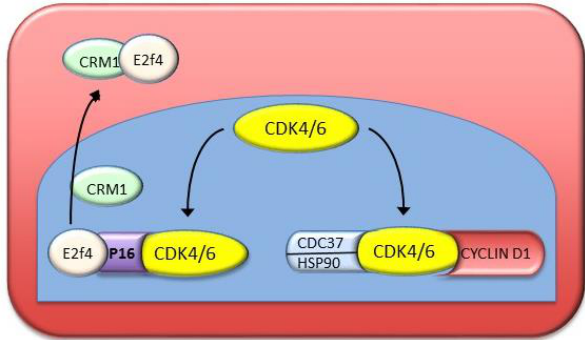
Figure 8. Protection by CDC37 / HSP90 and CRM1 of cell cycle G1-S progression from inhibition by p16 INK4A . In the nucleus, the formation of p16 INK4A complexes with CDK4 and CDK6 impedes the activity of Cyclins D. The complexes of the chaperons CDC37 and HSP90 with clyclin dependent kinases CDKs compete with p16 INK4A , hampering the formation of the inhibitory complex. The protein CRM1 complexes the p16 INK4A effector E2F4, relocating it to the cytoplasm, thus inactivating p16 INK4A .